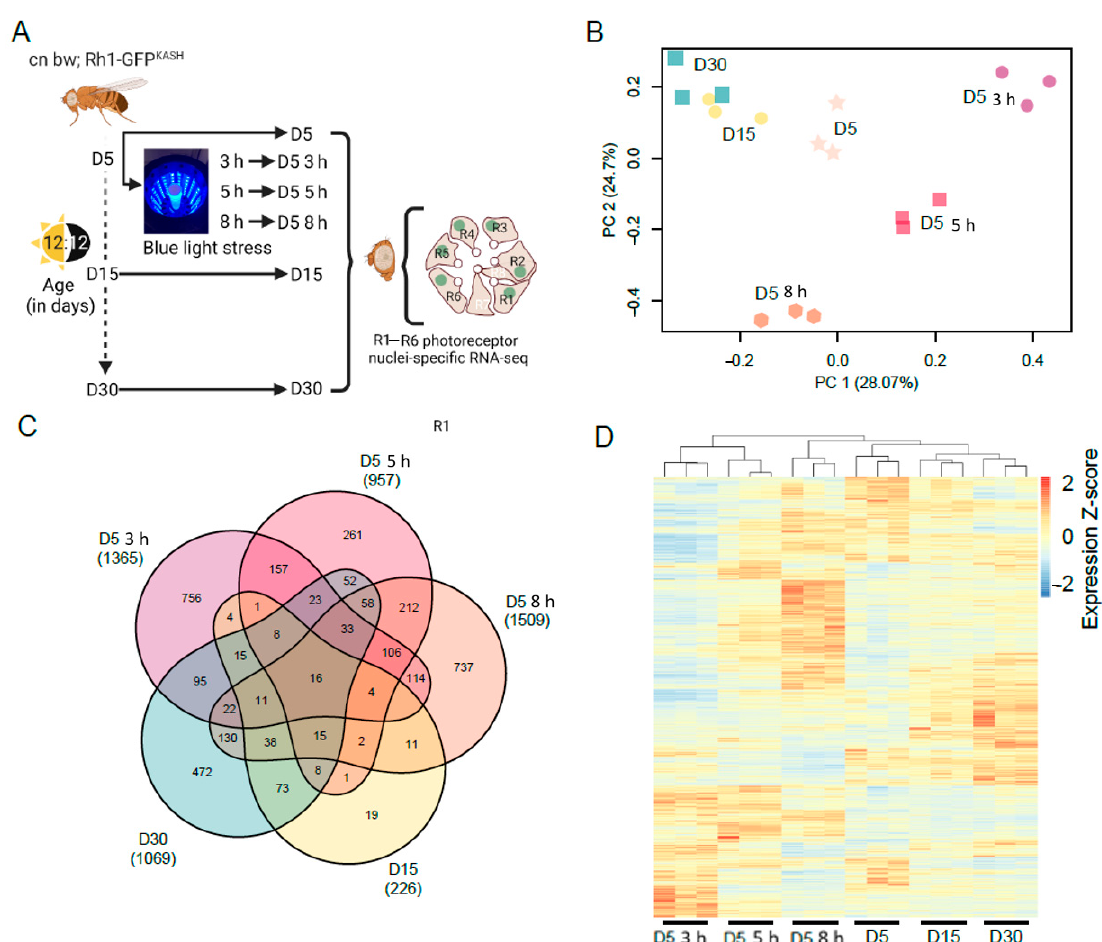
Figure 1. Global gene expression changes in white-eyed flies with age or blue light exposure. ( A ) Overview of the experi- mental design for photoreceptor nuclei-specific RNA-seq from blue light exposed or aged flies. Male white-eyed Rh1- GFP KASH flies at D5, D15 or D30, and D5 flies exposed to 3, 5, or 8 h of blue light were collected and photoreceptor nuclei- specific RNA-seq performed ( n = 3). ( B ) PCA analysis of aged or blue light exposed flies. ( C ) Venn diagram of the differ- entially expressed genes in aged or blue light exposed flies identified relative to D5 untreated. The total number of signif- icantly differentially expressed genes is shown under each sample name in brackets. ( D ) Hierarchical clustering of all differentially expressed genes in aged or blue light exposed flies. Normalized expression (Z-scores) were calculated for each gene (row).